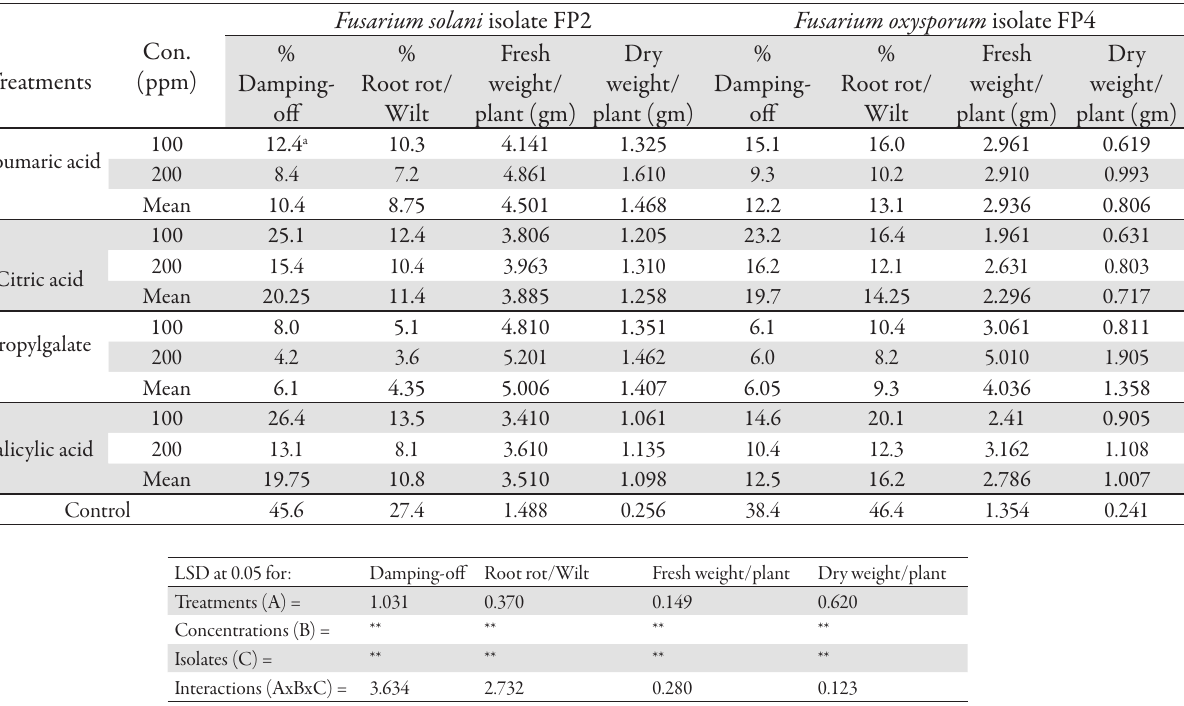
Tab. 3. Effect of soil drenching with antioxidant solutions on damping- off and root rot/wilt caused by Fusarium solani isolate FP2 and F. oxysporum isolate FP4 in pots